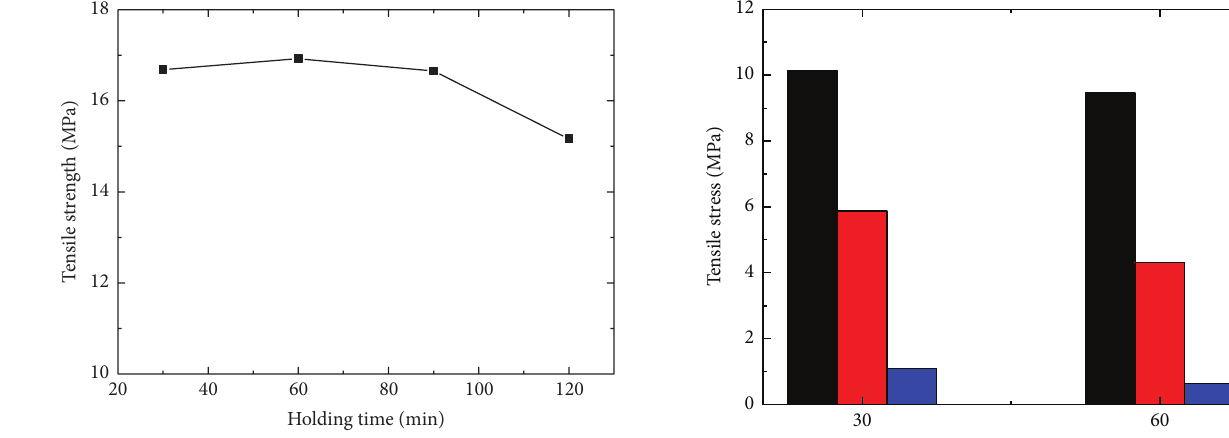
Figure 11: Tensile strength of the oriented linear porous metal with different holding times.